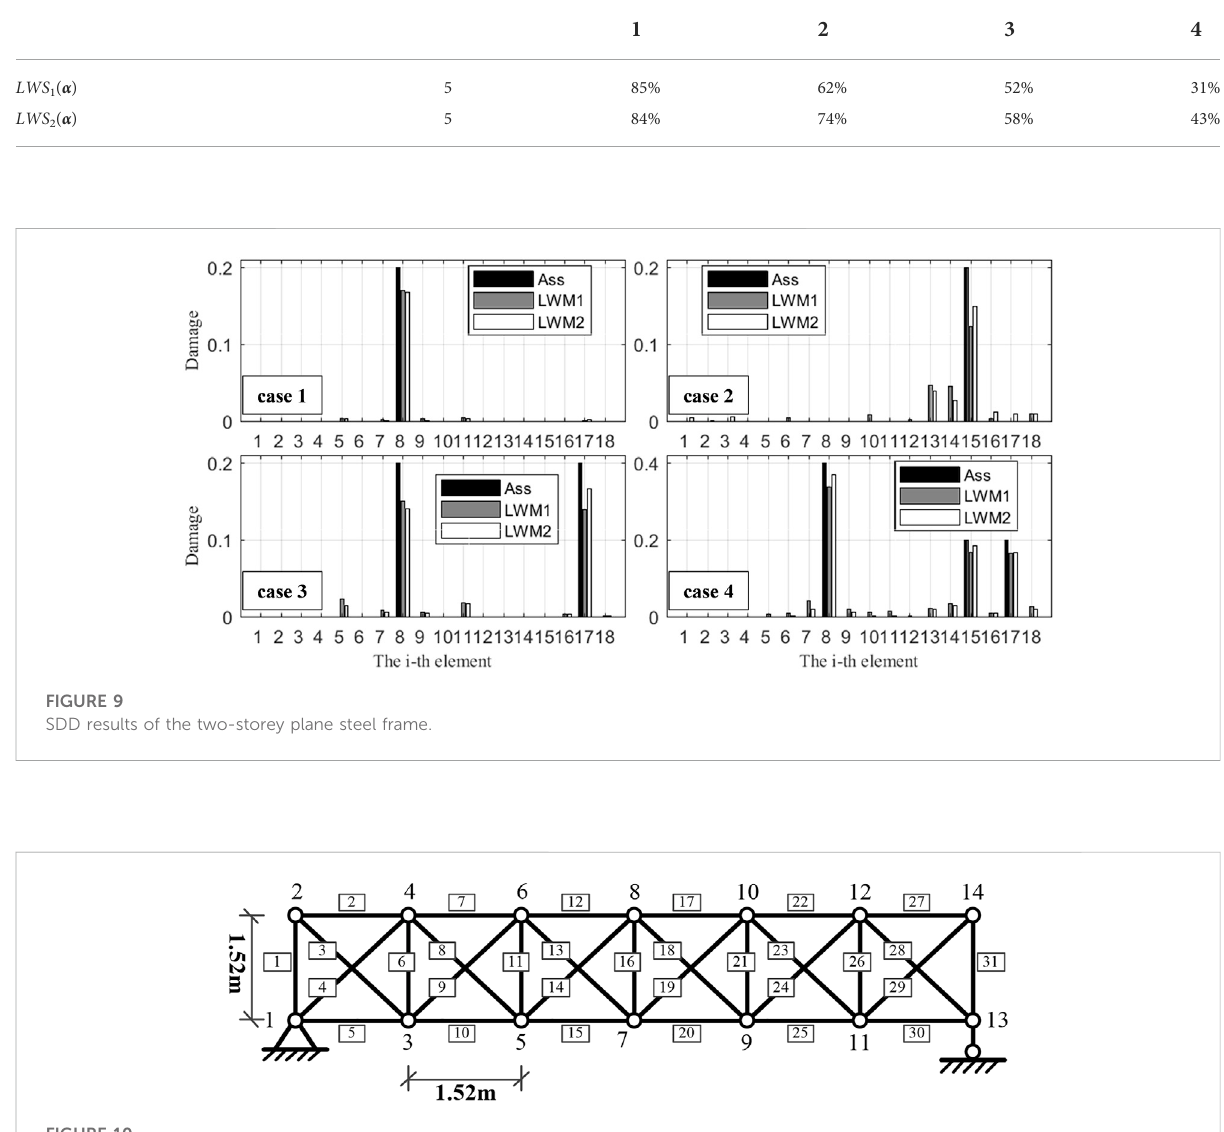
FIGURE 10 Finite element model of 31-bar planar steel truss.